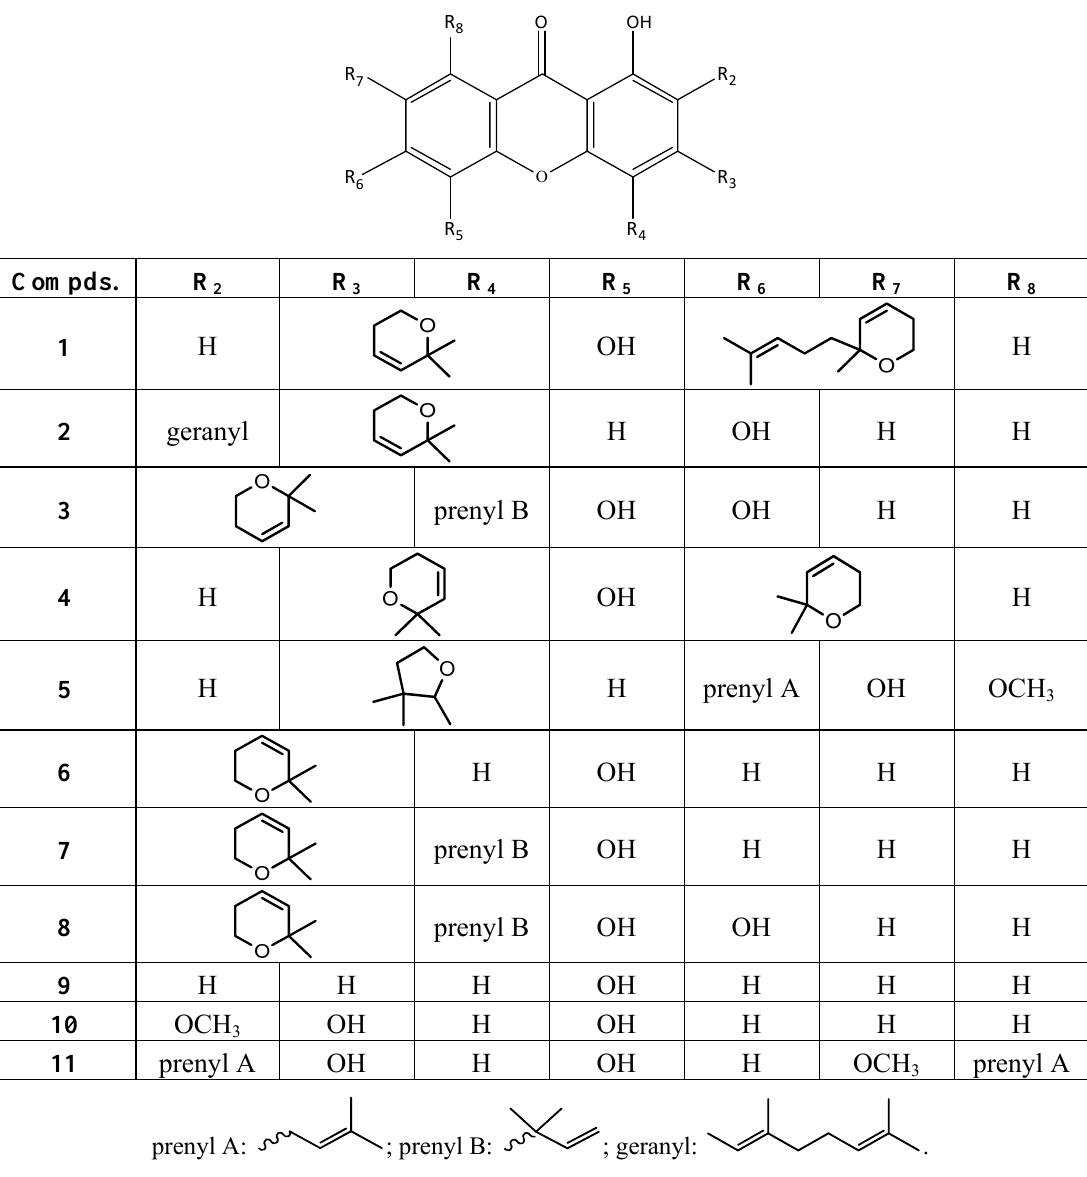
R 8 O OH R 2 R 7